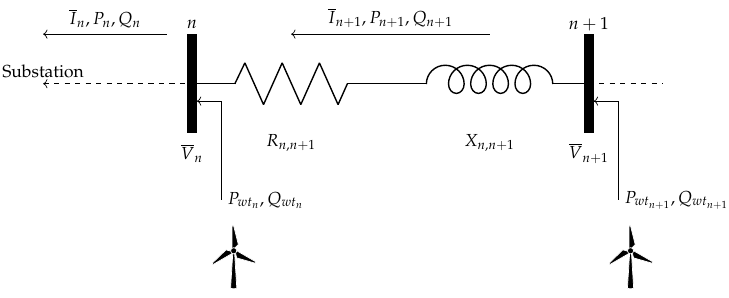
Figure 1. Line diagram of a radial distribution system.